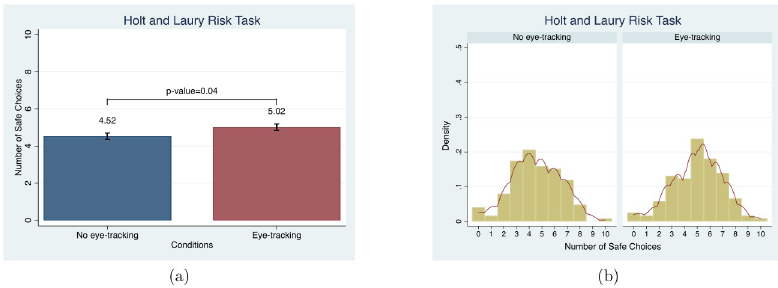
Fig 4. Mean and distribution comparisons in the number of safe choices. Note. Red lines in (b) present the univariate kernel density estimation.